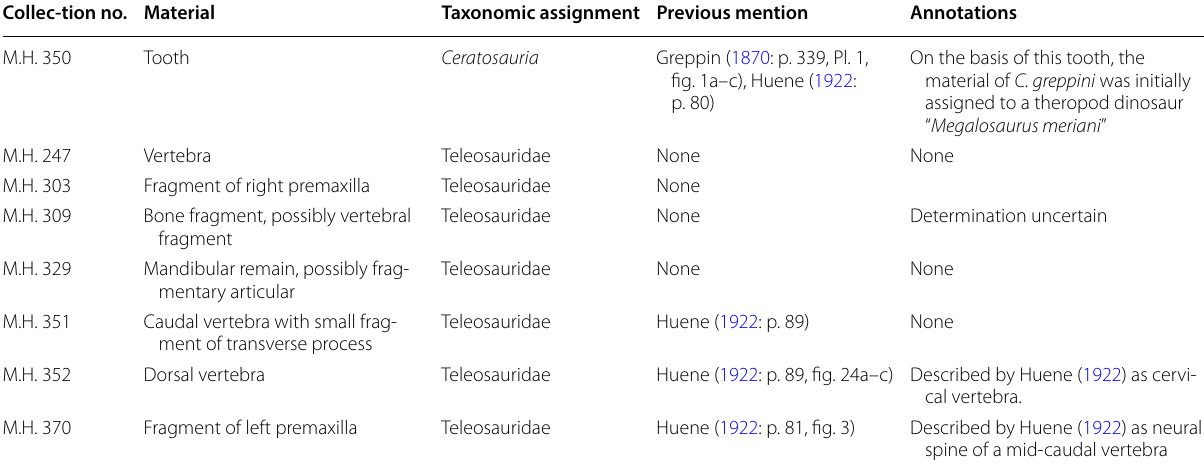
Table 2 List of other vertebrate material from Moutier, Switzerland, found together with A. greppini Collec-tion no.